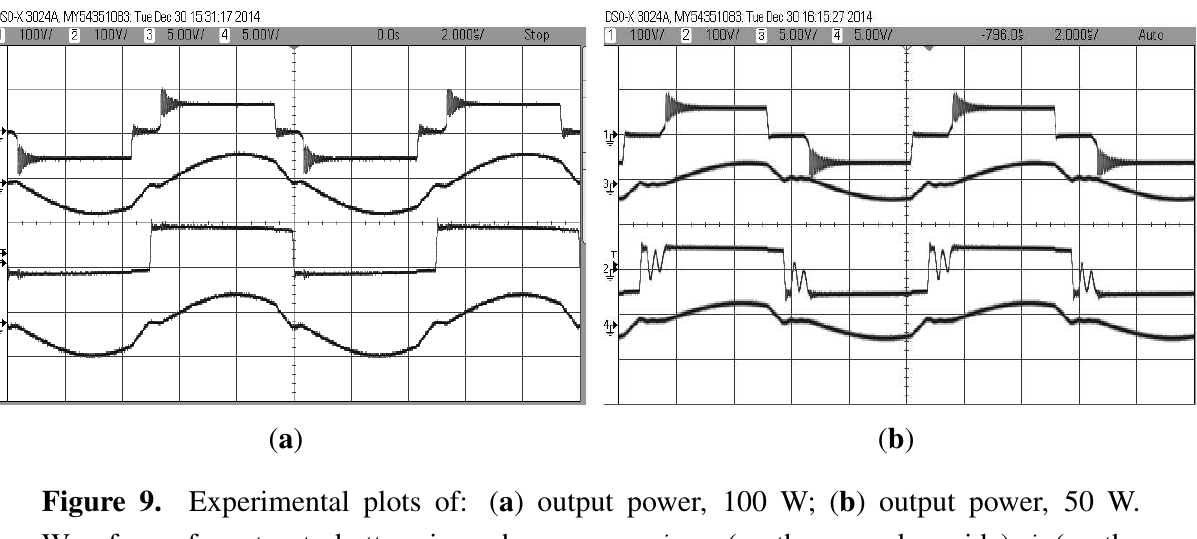
, i , v (on the secondary side), i AB s t